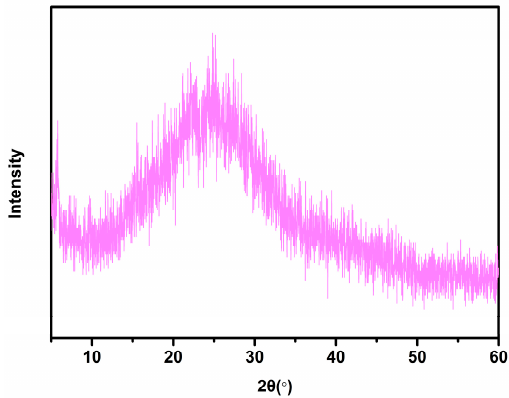
Figure 7. Wide angle X-ray diffraction pattern of polyimide (PI) nanofiber membrane.